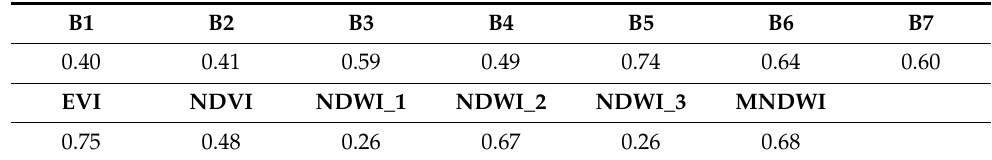
Table 3. Coefficient determination (R 2 ) of the linear relationship between the SIP and Landsat bands and derived indices.